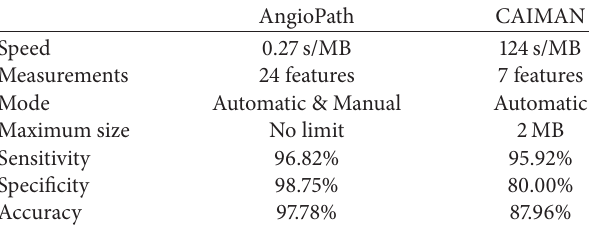
Table 3: Comparison of AngioPath versus